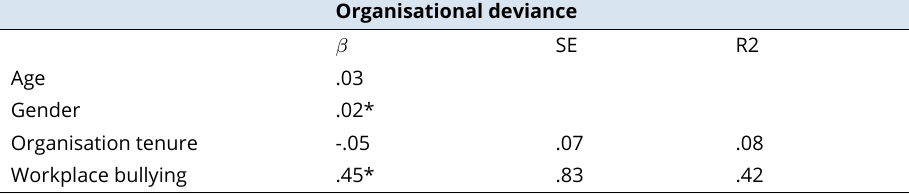
Results of Regression Analysis to test Direct Effect of Workplace Bullying on Organisational Deviance (H1)